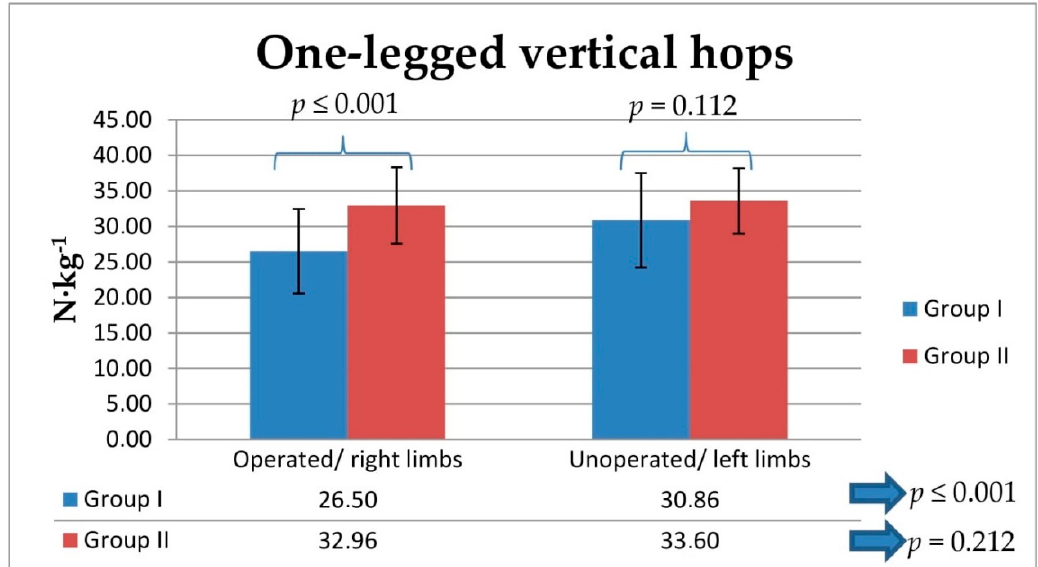
Figure 3. Comparison of the between-group and intragroup values of the vertical component of ground reaction forces during two-legged vertical hops, normalized for body mass, N·kg − 1 , in Group I and Group II. Statistical significance level ( p ).